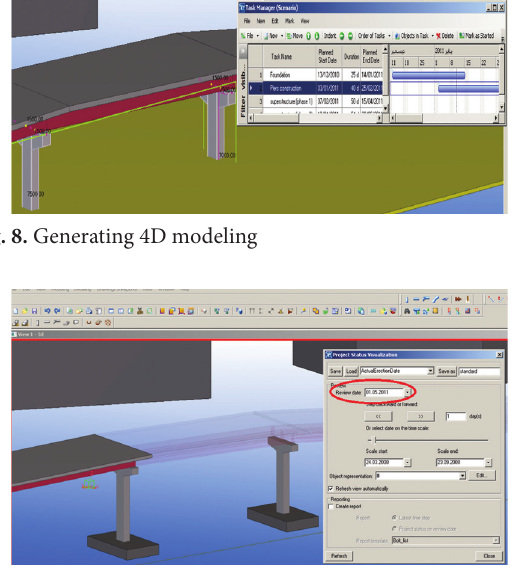
Fig. 9. Demonstrating project status at a specific date